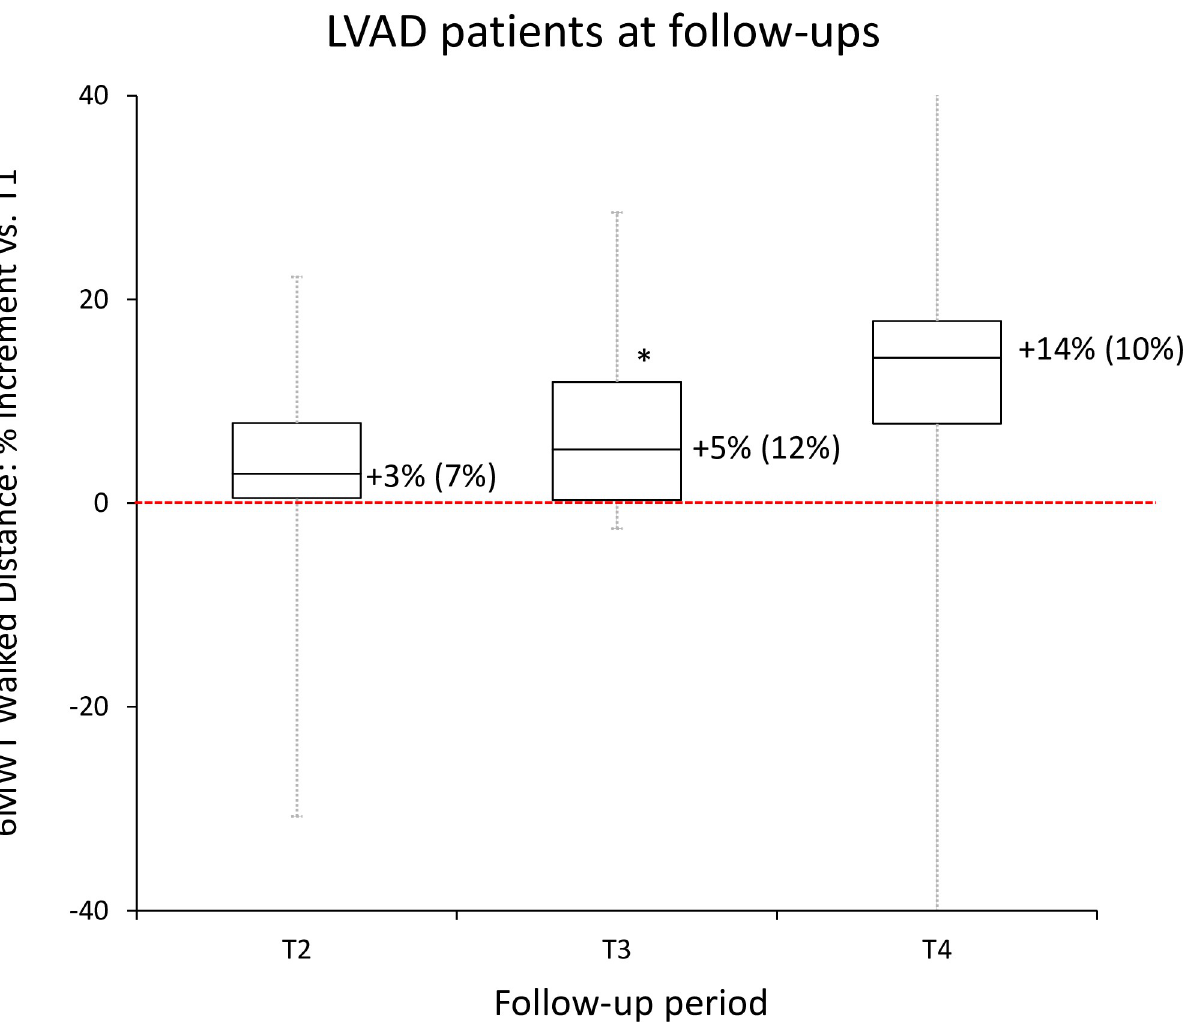
Fig 3. LVAD patients: Box-and-whiskers plot representing the percent change of the distance walked during the six-minute walk test at the T2, T3, and T4 follow-ups compared with the reference value at hospital discharge (T1, dashed red line). The whiskers show the maximum-minimum range, the box shows the first and third quartile, with the median; the label close to each box reports the median (interquartile range) values; the � indicates when the median value significantly differs from the reference at p < 0.05.